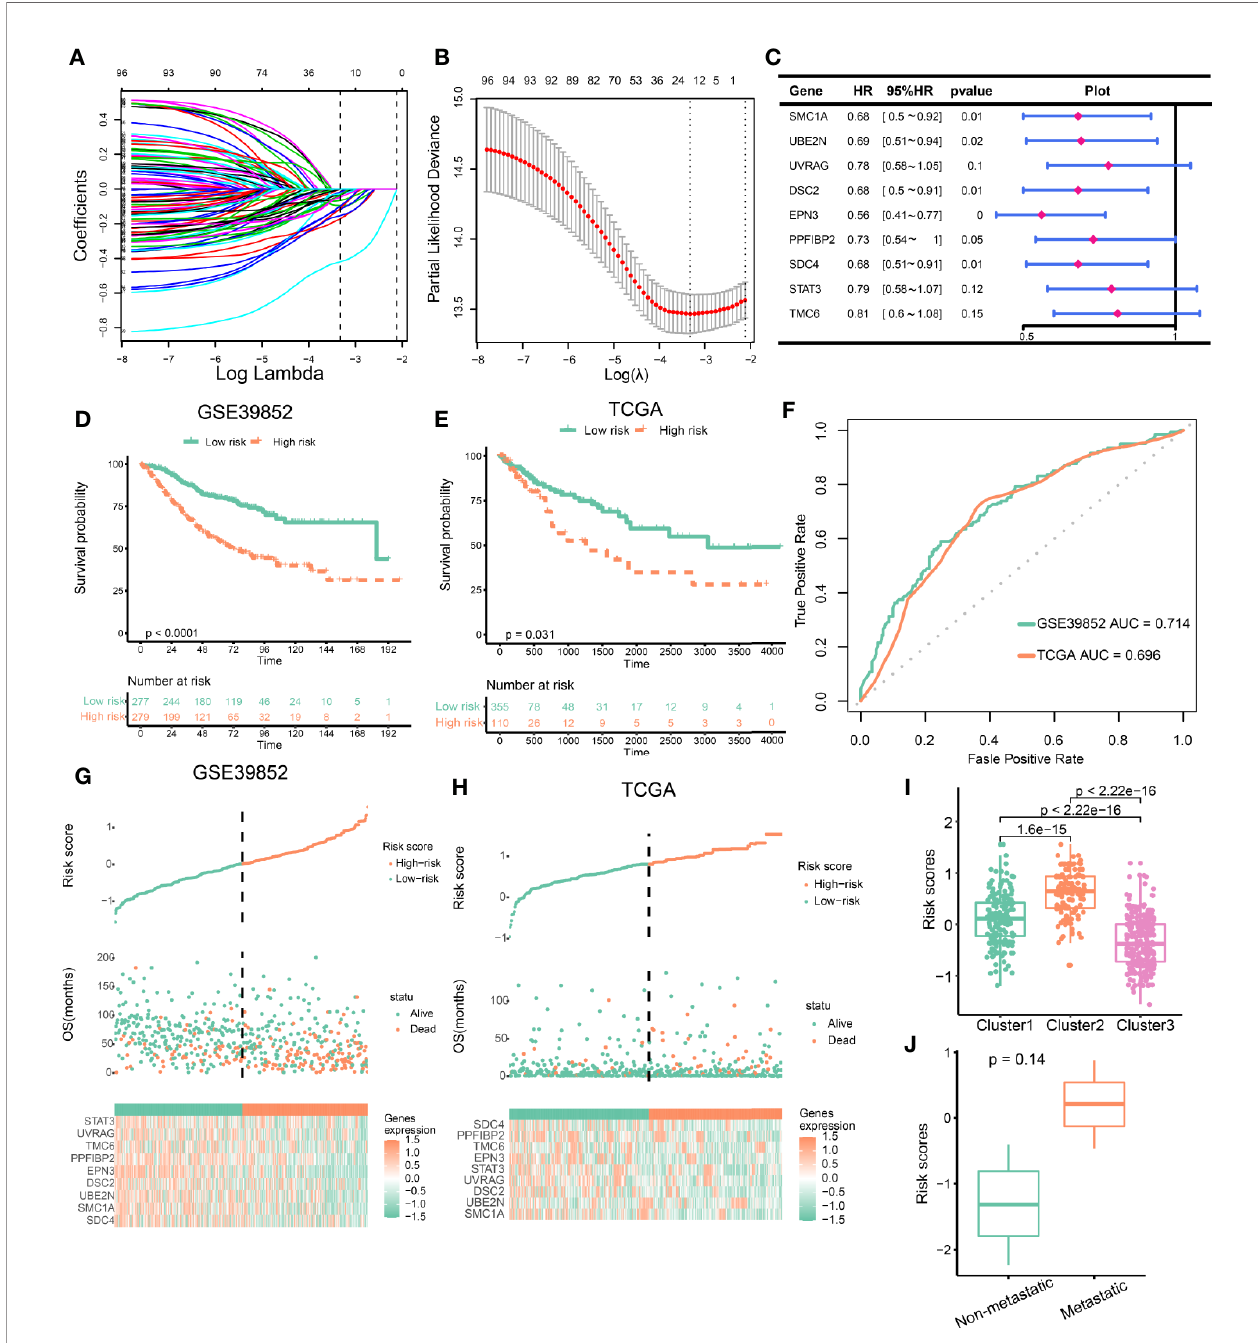
FIGURE 6 | Construction of epithelial mesenchymal transformation (EMT) and DNA repair risk scores. (A) LASSO regression coef fi cient pro fi les of 98 EMT and DNA repair genes. (B) Tuning parameter ( l ) selection in the LASSO regression used 10-fold-cross-validation via minimum criteria. The black vertical lines are plotted at the optimal l based on the minimum criteria and 1 standard error for the minimum criteria. (C) The hazard ratios and p-values of the 9 genes in the risk model. (D) Kaplan – Meier curves of overall survival for patients in GSE39582 strati fi ed by risk scores. (E) Kaplan – Meier curves of overall survival for patients in TCGA strati fi ed by risk scores. (F) The ROC curves for the risk model in GSE39582 and TCGA. (G, H) Construction and analysis of risk scores. The top panels indicate the risk scores of the patients. The middle panels depict the survival statuses and survival times of the patients distributed by risk score. The bottom panels display the heatmap of the expression for the nine genes distributed by risk score. (G) GSE39582 cohort; (H) TCGA cohort. (I) Comparison of risk scores across clusters. (J) Risk scores in metastatic VS. non-metastatic colorectal cancer (CRC)